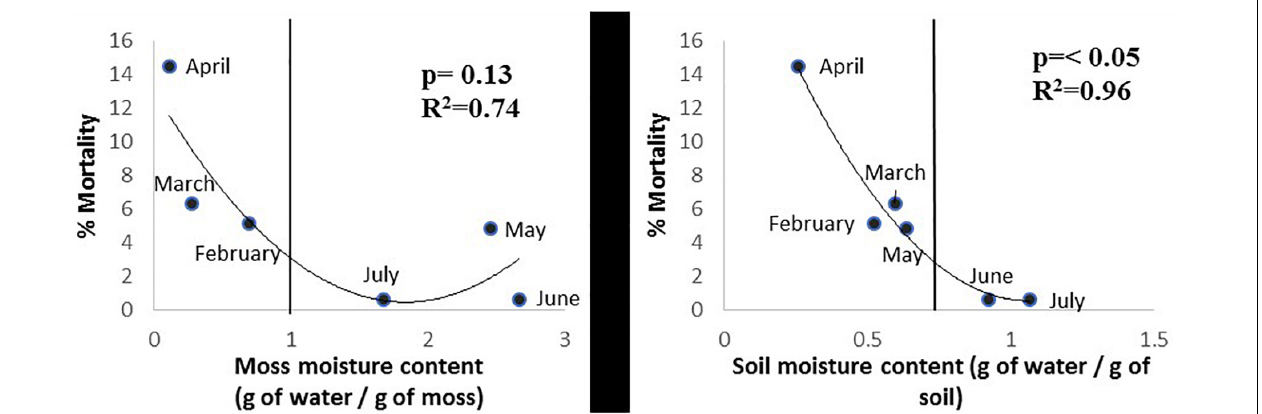
FIGURE 6 | Quadratic regression of seedling mortality against: (left) moss moisture content, (right) soil moisture content. (Vertical black line indicates what appears to be a critical humidity threshold in relation to seedling mortality).